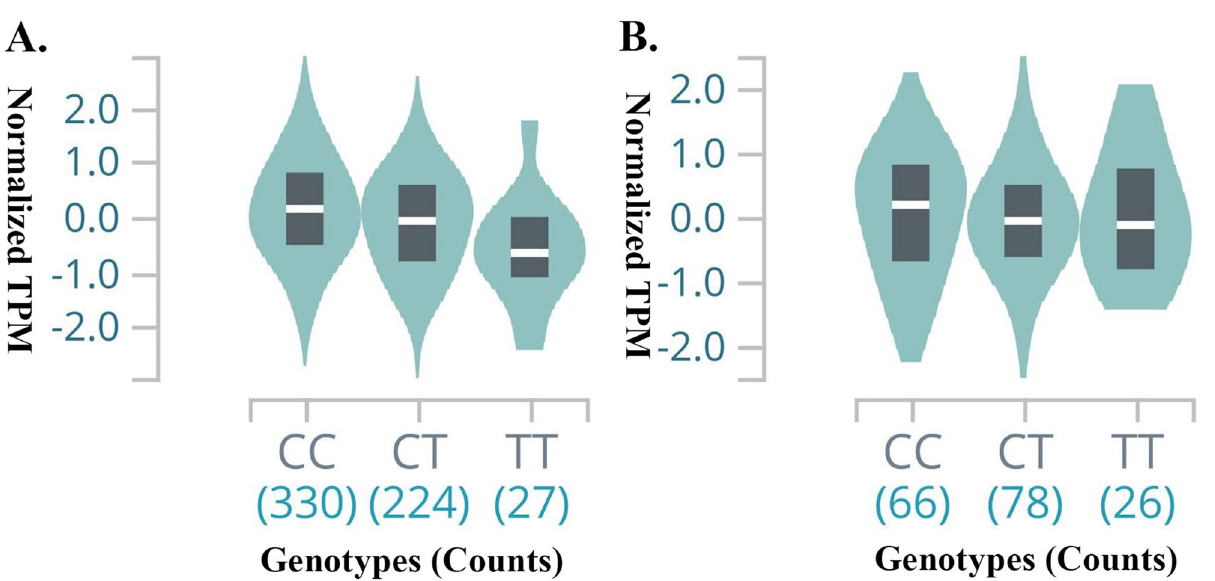
Figure 2. Violin plots for genotypes of SNP rs10456100 and rs7775721 on gene expression level of KCNK5 and FHL5 . ( A ) Violin plot for genotypes of SNP rs10456100 on KCNK5 gene expression levels in human tissue of subcutaneous adipose; ( B ) Violin plot for genotypes of SNP rs7775721 on FHL5 gene expression levels in human tissue of brain